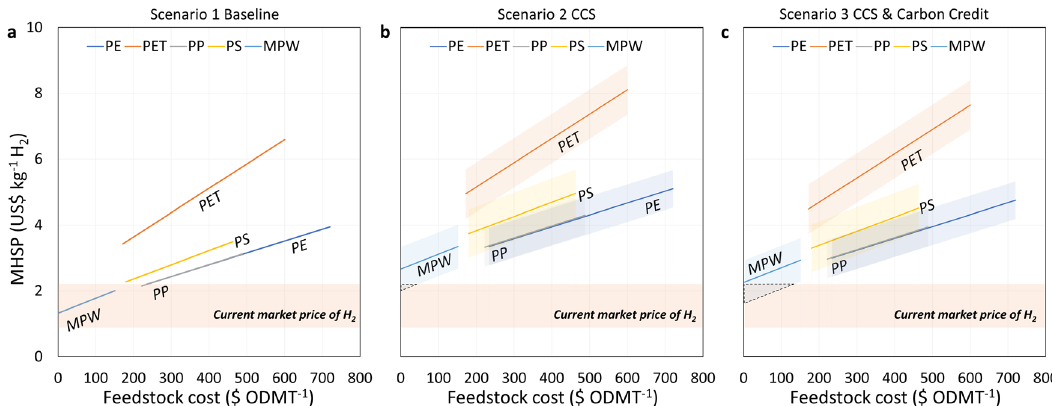
Fig. 3 Minimum hydrogen selling price of 2000 oven dry metric tons per day hydrogen plants in Scenarios 1 – 3 with varied feedstock cost. a Scenario 1 baseline; b Scenario 2 CCS; c Scenario 3 CCS & Carbon Credit. The shaded areas of Scenario 2 (Fig. 3b) and Scenario 3 (Fig. 3c) cover the uncertainty of MHSP results with varied CCS costs. The triangular dashed line boxes in Fig. 3b and c mark the areas where MHSP is economically competitive compared with the current market price of H 2 . The current market price of fossil-based hydrogen ranges from US$0.91 to US$2.21 kg − 1 H 2 (without CCS) (see Supplementary Table 3), which are highlighted as economic Fig. 3b, only Scenario 2-MWP achieves MHSP comparable to fossil-based H 2 (as marked with the triangular dashed line box) when the CCS cost and the MPW feedstock cost is low. For example, in Scenario 2-MPW, lowering the MHSP to US$2.21 kg − 1 H 2 (the highest price of H 2 from fossil fuels without CCS) requires